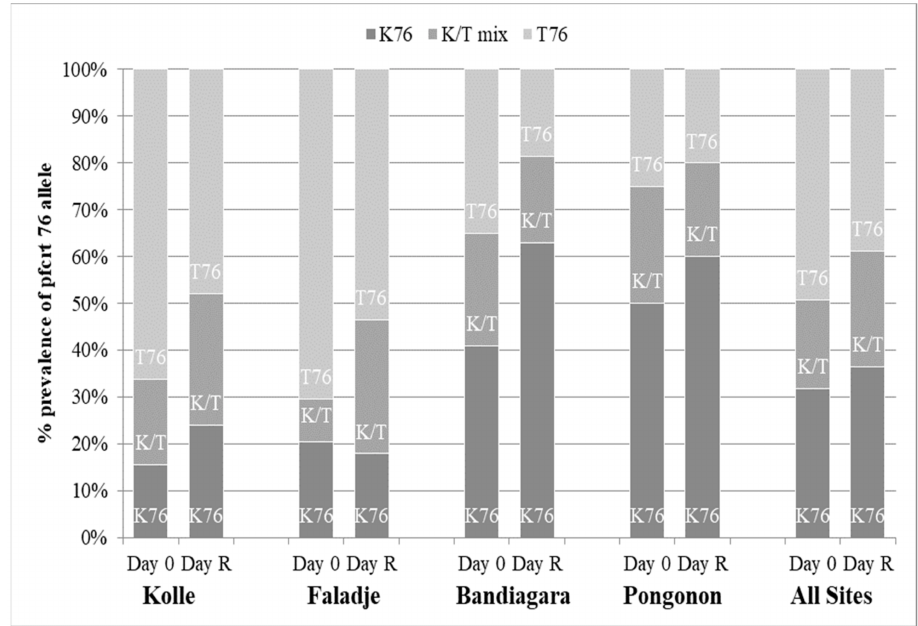
Figure 4. Pfcrt allele frequency. D0 = date of enrollment; Day R = date of recurrent